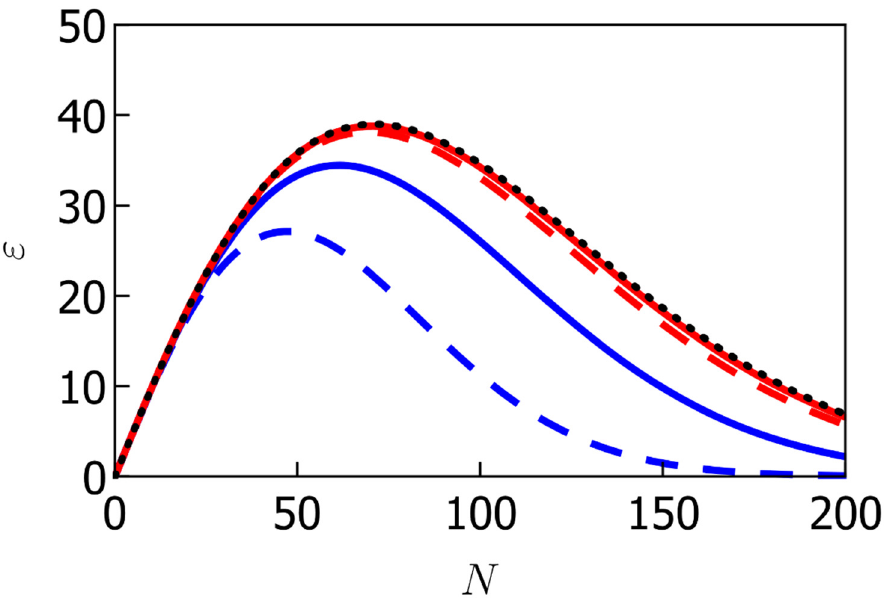
Figure 12. Relation between ε and N given by Equation (31), with σ f = 1 cm, T K = 6 µ K, Ω 0 = 2 π × ( 200 MHz ) . The black dotted curve shows the case where σ 0 = 0, which is identical to the red curve in Figure 11 because in this case there is no effect of the finite initial size of the atomic cloud. The red curves are the plots for σ 0 = 0.1 mm, while the blue curves are for σ 0 = 0.5 mm. The solid (dashed) curves correspond to an angular velocity of 1(2) µ Hz. We can see that the larger the initial size is, the less LMT can improve the